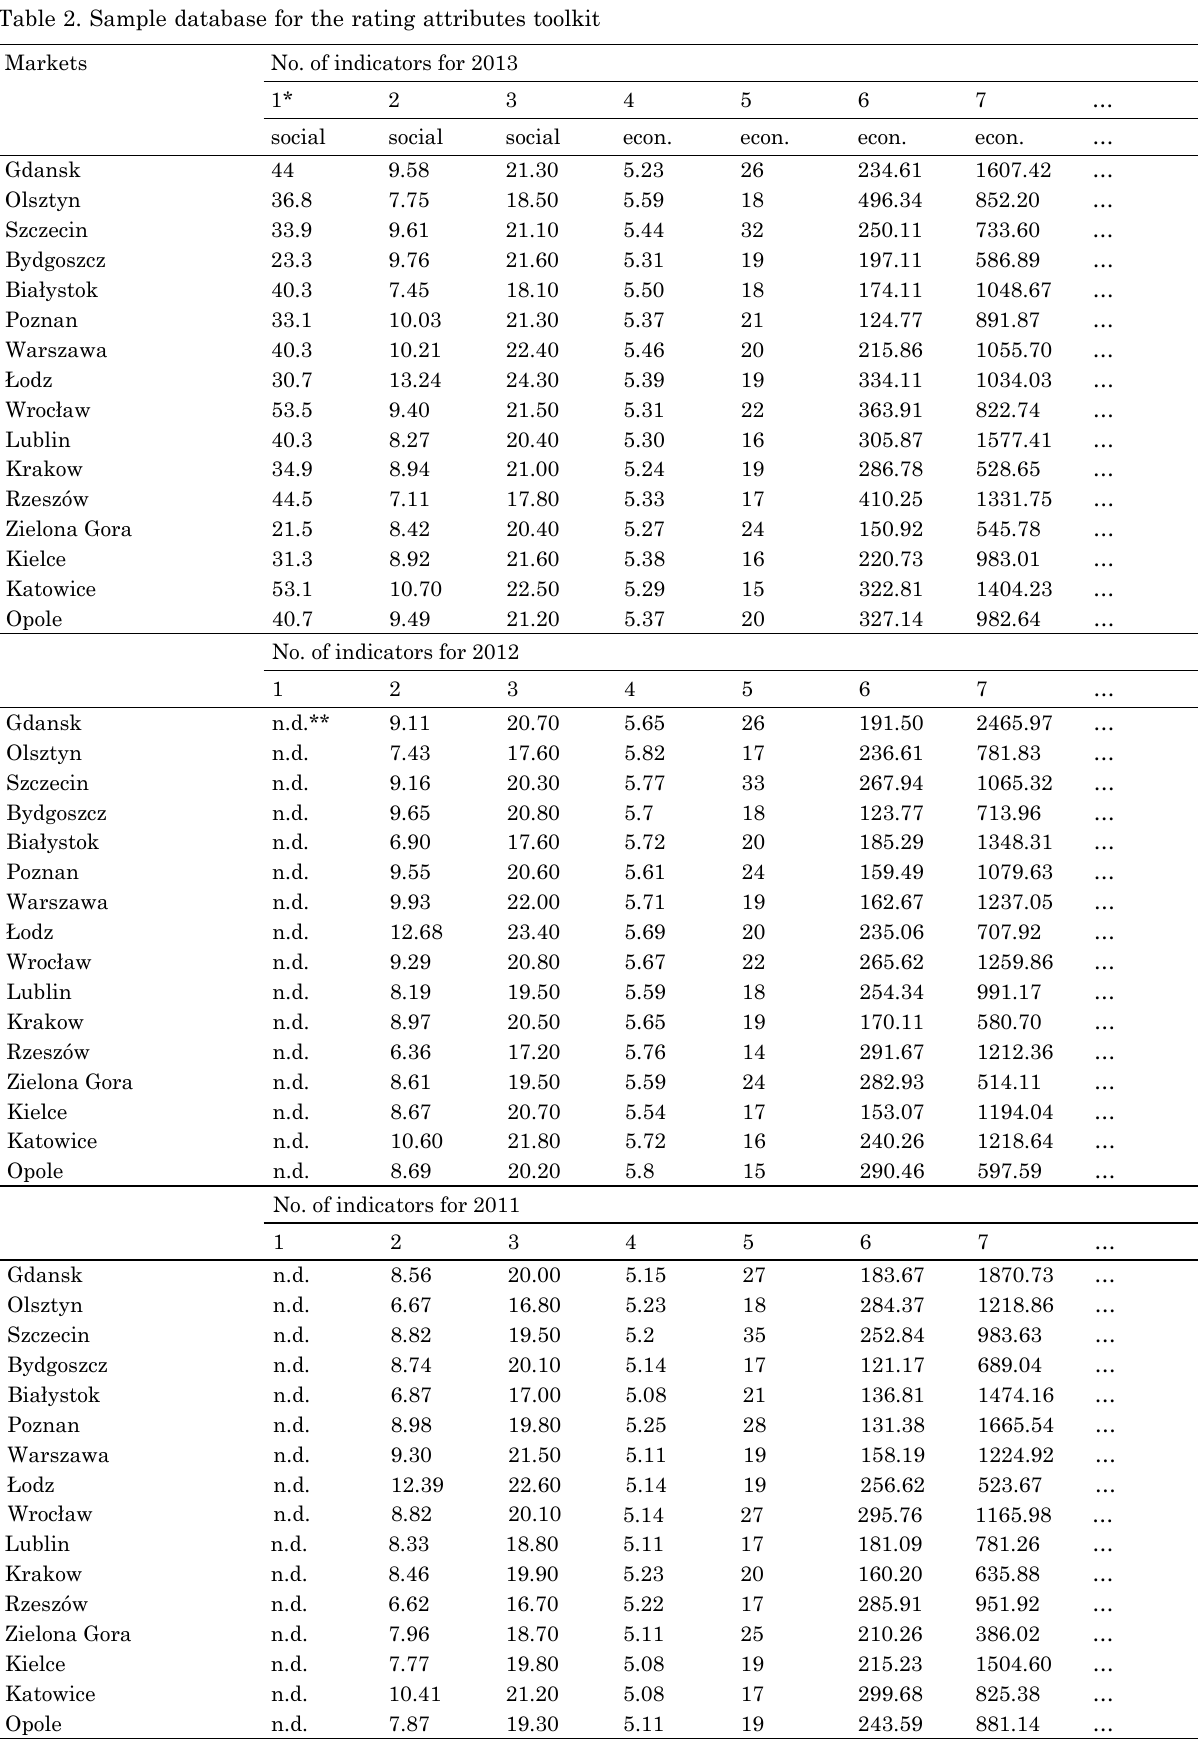
Table 2. Sample database for the rating attributes toolkit Markets